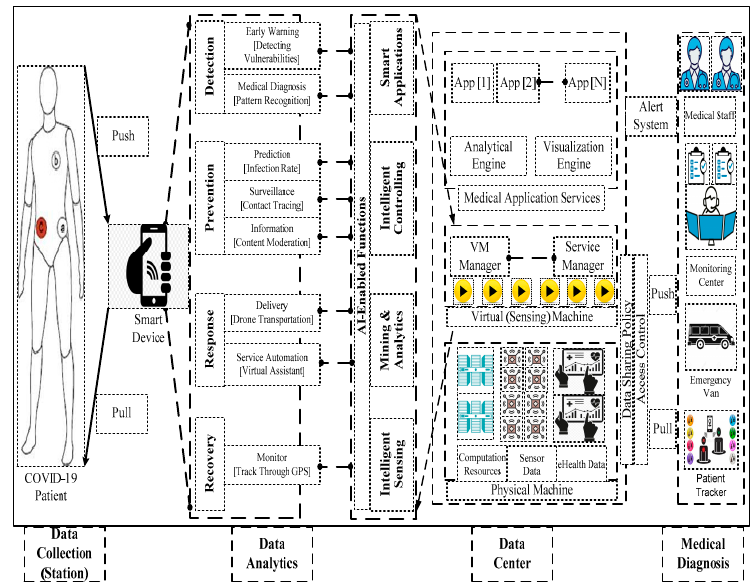
Figure 1. An intelligent Edge-IoT model—a cognitive-aware system.